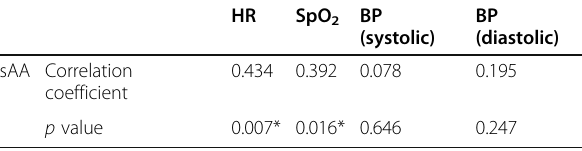
Table 4 Correlation between the differences in the observed parameters after